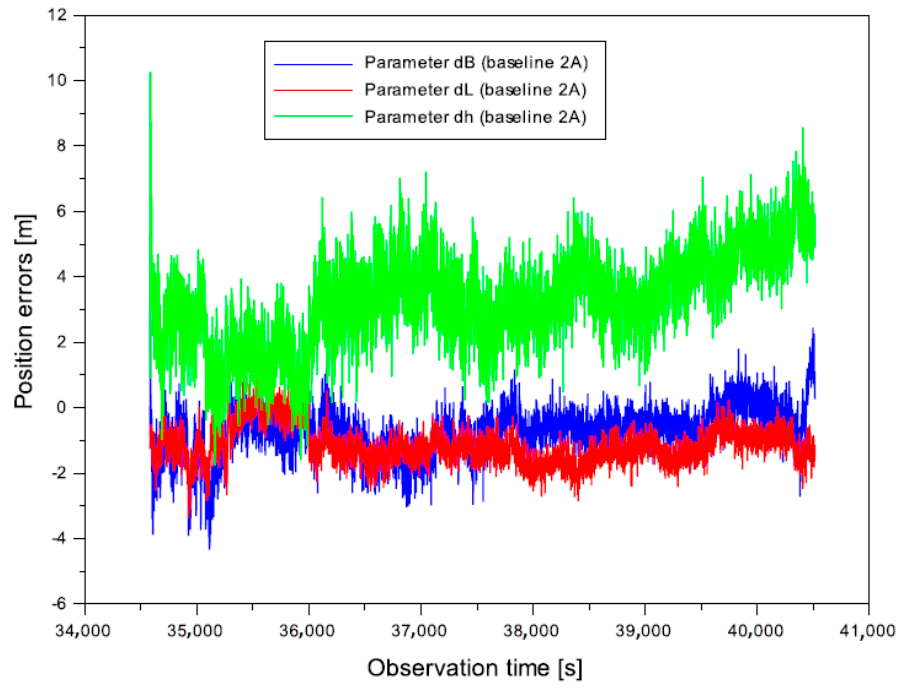
Figure 3. The results of position errors for baseline 2 A .